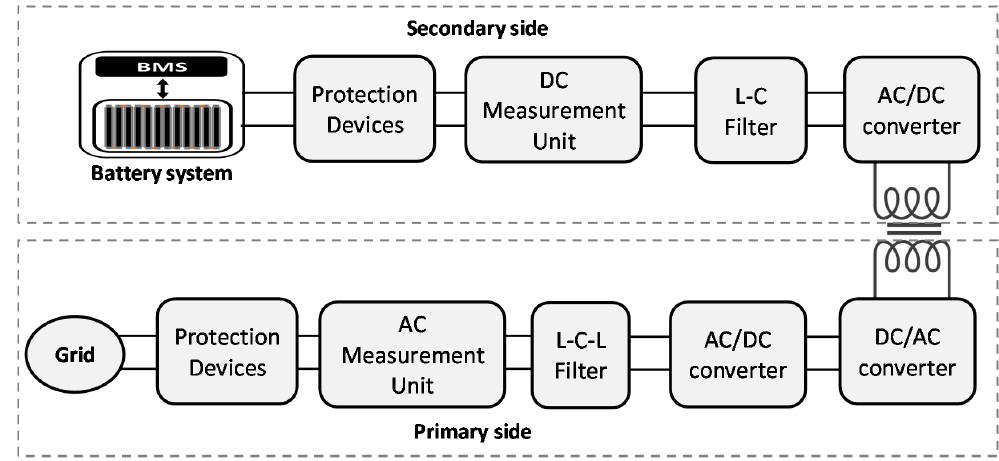
Figure 2. Example of the structure of an Inductive Charger.